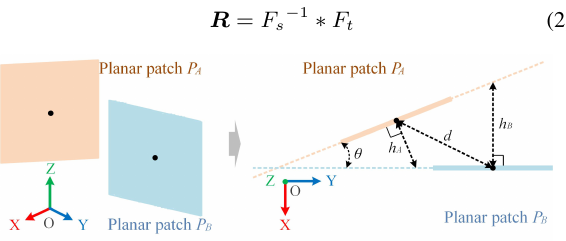
Figure 4. Measuring of coplanar criteria between two patches